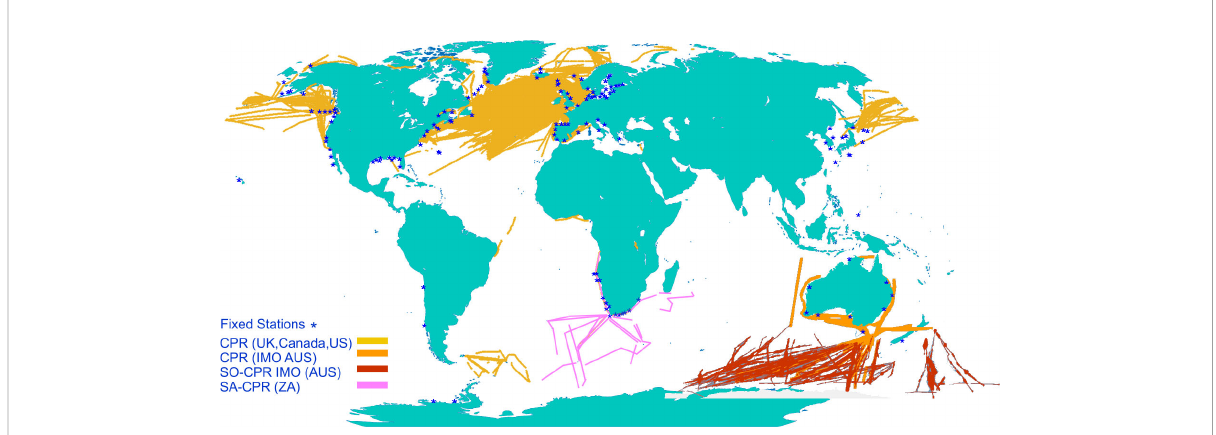
FIGURE 1 World map overlaid with fi xed net sampling stations and Continuous Plankton Recorder tracks (adapted from source: MBA CPR map 1958-2020 (Batten et al., 2019), with data from NOAA Copepod database (O ’ Brian and Oakes, 2020), Australian IMOS database 1993-2021 (Re3Data.org, 2021) and South African CPR 2005-2021 (Huggett, pers.